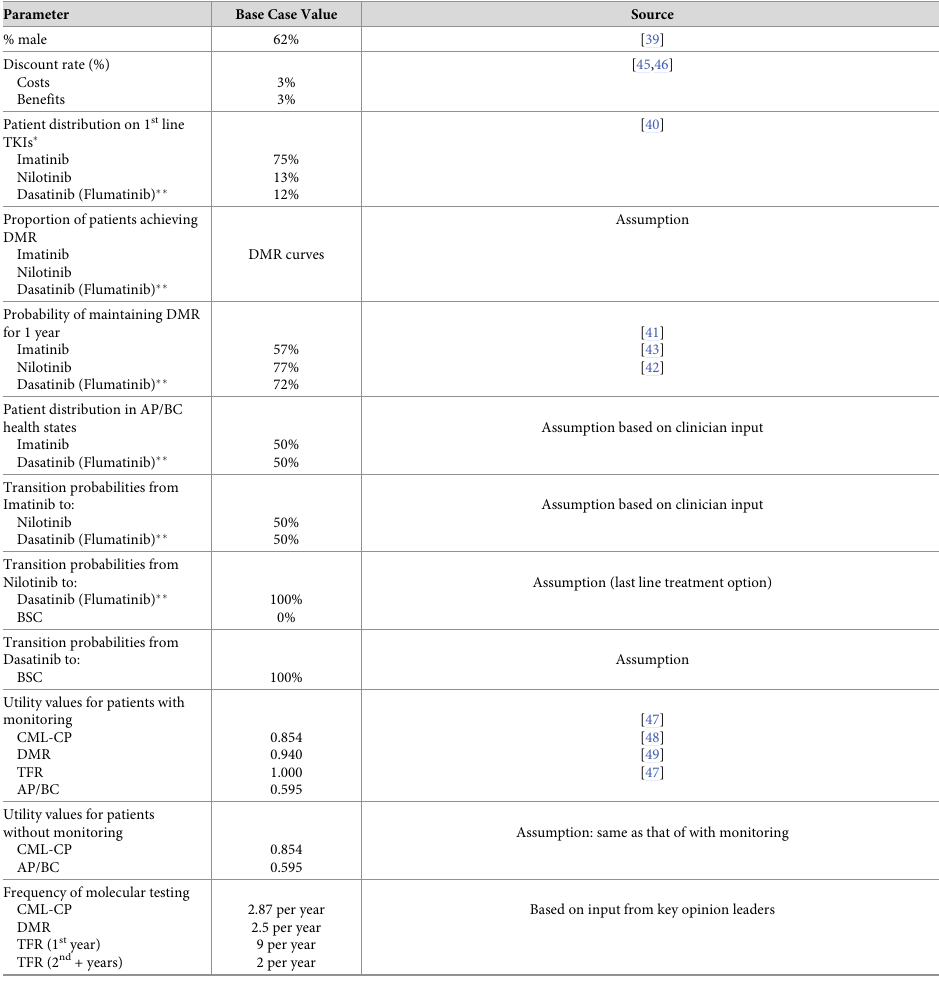
Table 1. Clinical inputs for base case